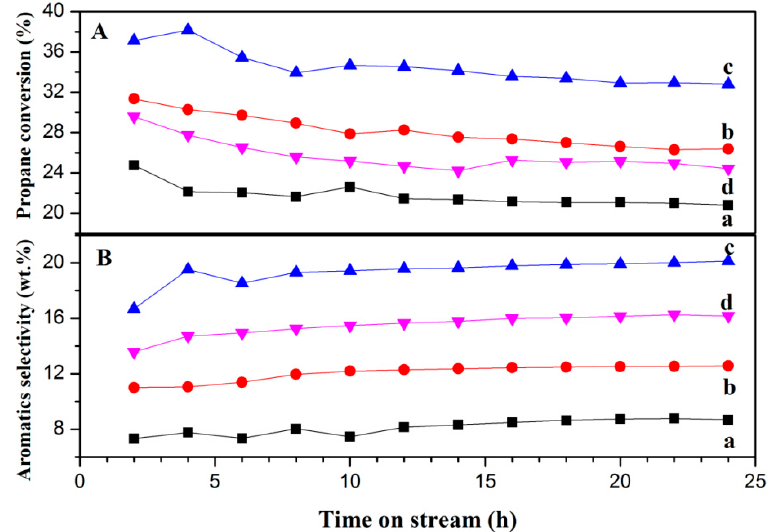
Figure 5. Propane conversion ( A ) and aromatics selectivity ( B ) with the time on stream (TOS) over HZSM-5 catalysts: HZ(0) (a), HZ(0.4) (b), HZ(0.8) (c) and HZ(1.1) (d). at 550 °C with weight hourly space velocity (WHSV) of propane being 0.6 h − 1 and N 2 /C 3 H 8 ratio being 2.5 in feedstock.